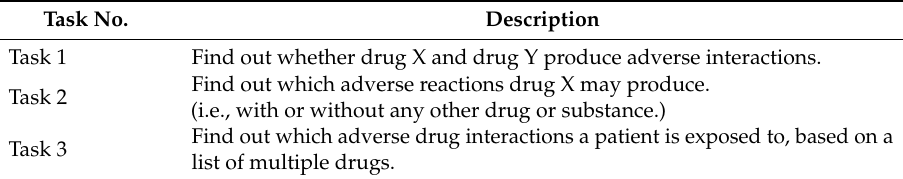
Table 1. Goal-oriented tasks applied in heuristic evaluations.